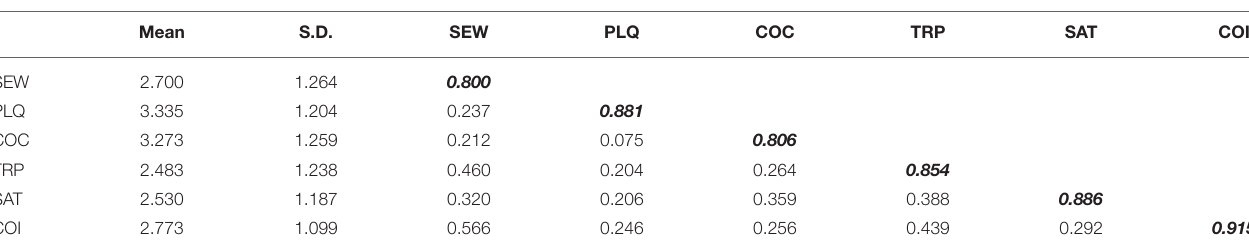
TABLE 3 | Results of discriminant validity testing.